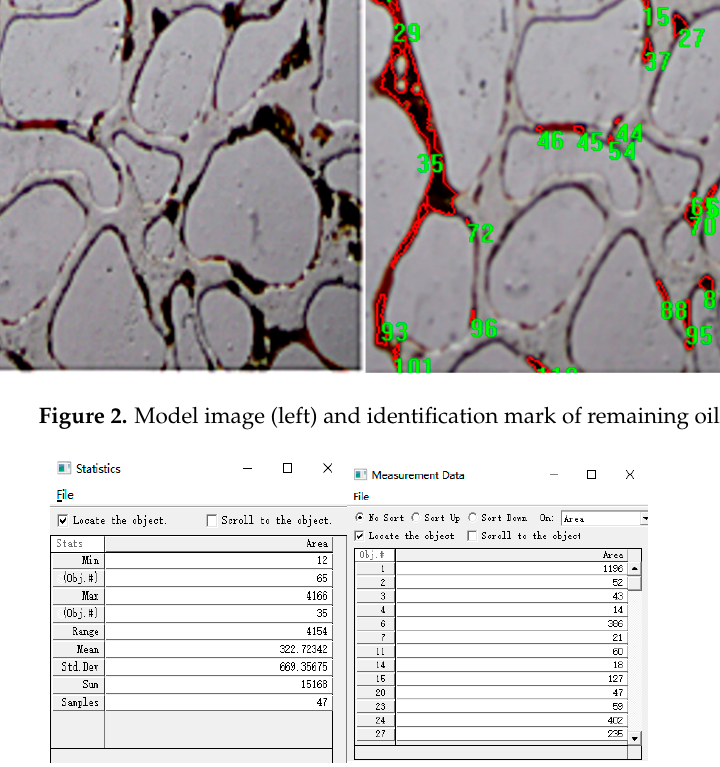
Figure 3. Statistics and calculation of remaining oil in each region of the model by software.